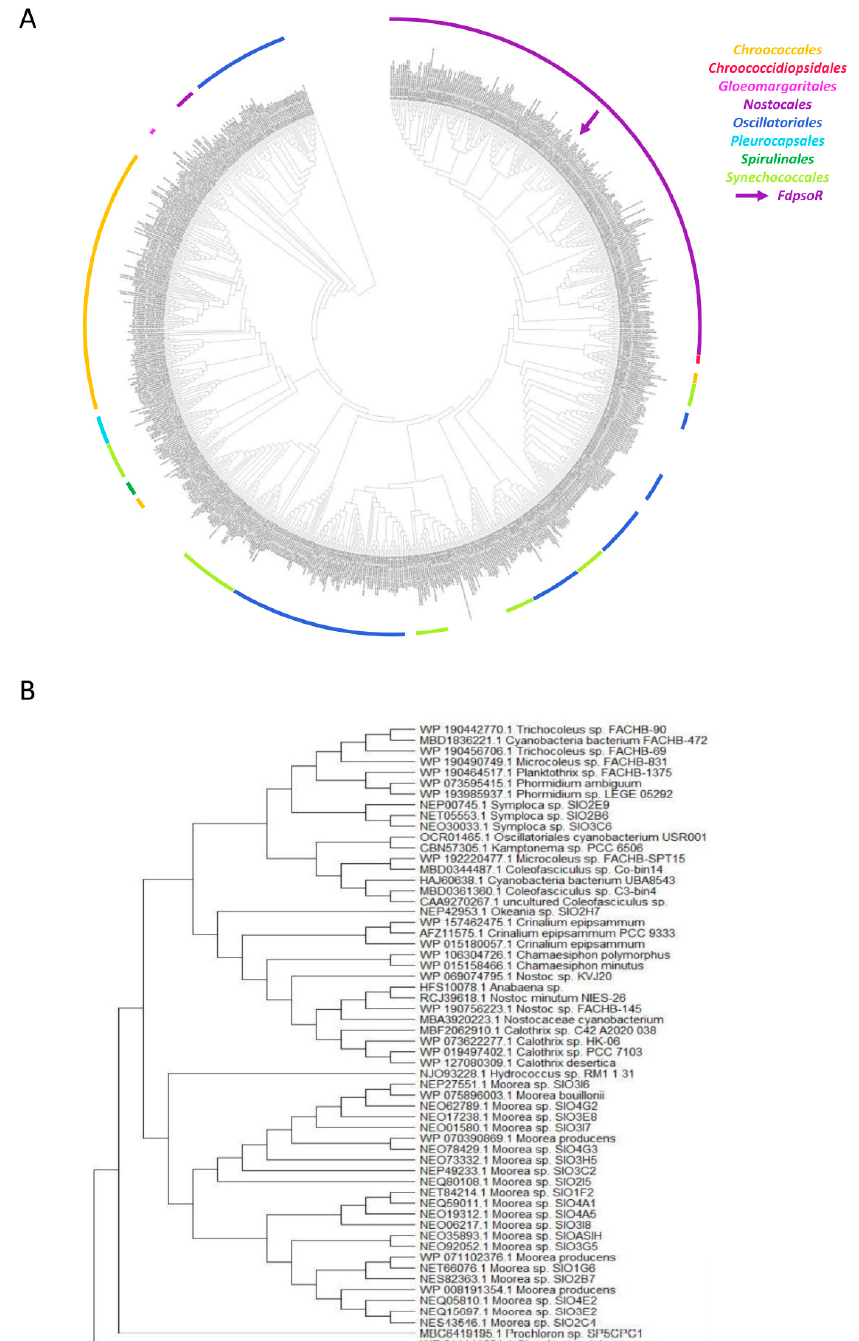
Figure 4. Phylogenetic tree of PsoR within cyanobacteria. Protein sequences of PsoR homologs from cyanobacteria were identified using Fd PsoR as the query sequence with the PSI-BLAST (Position- Specific Iterated BLAST) algorithm on the NCBI website [38]. The identified PsoR homologs were aligned through the MEGA-7 program using MUSCLE [39]. ( A ) A phylogenetic tree was created using the maximum likelihood method and Jones-Taylor-Thornton matrix-based model in MEGA-X [40]. The likelihood log was − 746644.20. An unrelated β -CASP protein from Gloeobacter violaceus (Gene ID: WP_011141021.1) was used to root the phylogenetic tree. Colors indicate clusters of cyanobacterial orders. ( B ) Phylogenetic tree of the PsoR homolog branch closest to the Gloeobacter violaceus